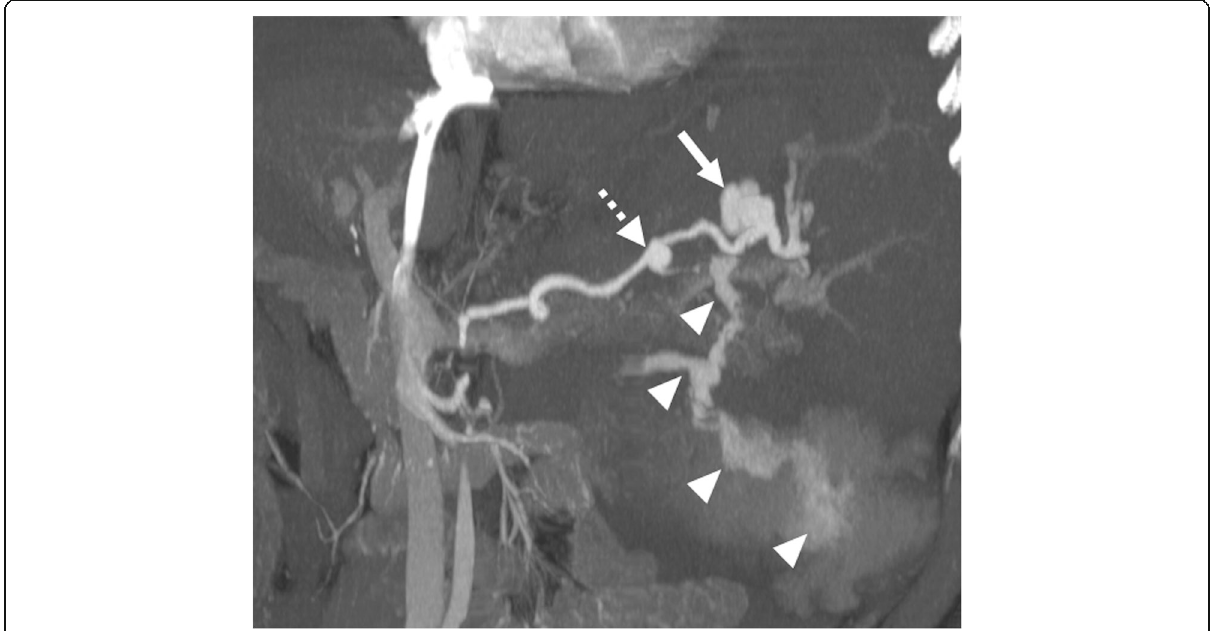
Fig. 28 Splenic artery aneurysm. A 48-year-old male with known hepatitis B associated chronic liver disease presented to ED with acute onset severe abdominal pain and hypotension. Coronally reformatted post-contrast MIP image demonstrates a large lobulated splenic artery aneurysm (arrow) in the distal part of splenic artery. There was marked contrast extravasation from this aneurysm (arrowheads) consistent with acute rupture. Also, note is made of another smaller aneurysm (broken arrow) located in the proximal part of the splenic